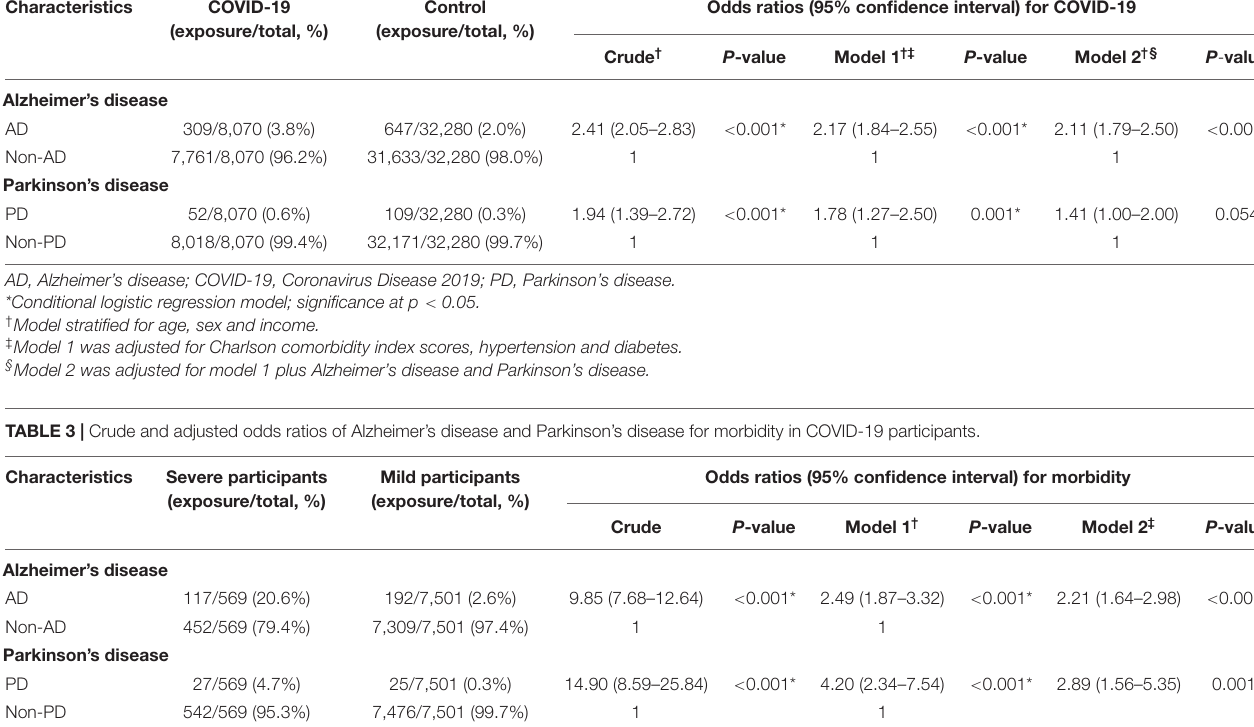
TABLE 2 | Crude and adjusted odds ratios of the association between pre-existing Alzheimer’s disease or Parkinson’s disease and COVID-19 in the total study participants. Characteristics